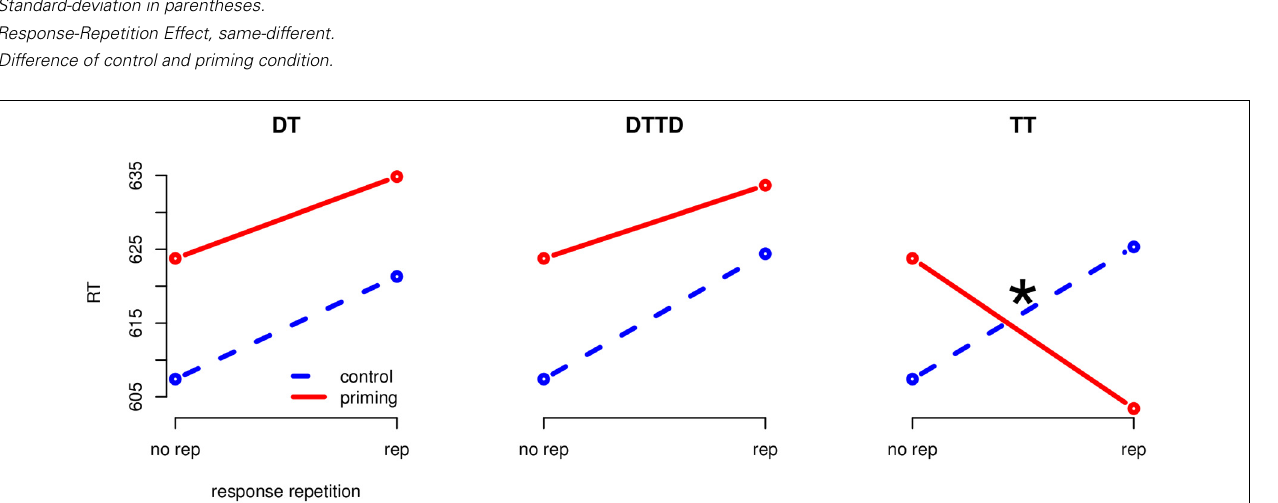
FIGURE 2 | Separate interaction plots for all priming conditions (Experiment 1). Blue, stippled line is the control condition, red solid line the corresponding priming condition. The “ ∗ ” indicates significance at the 0 . 05